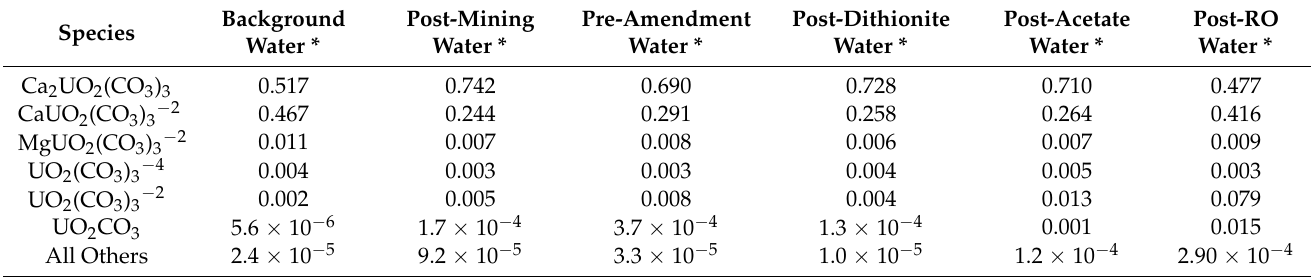
Table 2. Calculated fractions of dissolved uranium species present in a typical background water, a typical post-mining ore-zone water, and at various stages during the amendment test at SRH. Also shown is the U speciation in a water that approximates ore-zone water after typical reverse osmosis